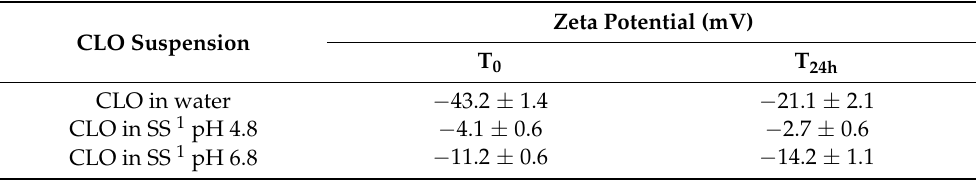
Table 4. Zeta potential of CLO suspensions after T 0 and T 24h at 25 ± 1 ◦ C (mean ± SD, n = 3). CLO